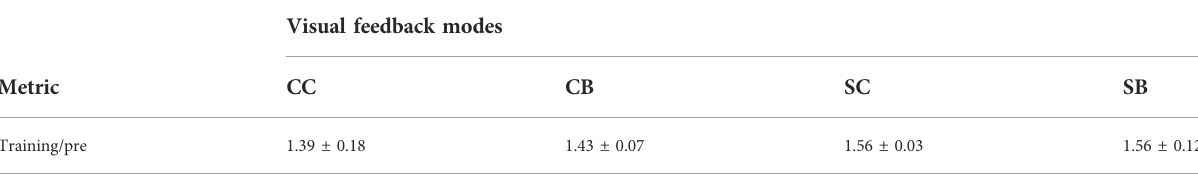
Table 5B: Two-way ANOVA results based on factors of complexity and intermittency